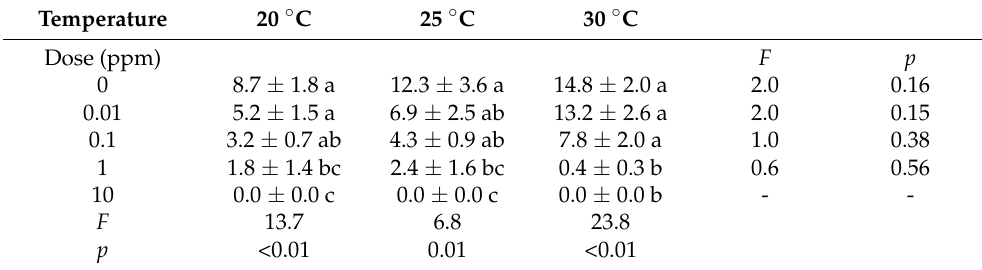
Table 6. Progeny production (adults per vial ± SE) of Prostephanus truncatus on maize treated with the SC formulation of chlorantraniliprole at five doses (0, 0.01, 0.1, 1 and 10 ppm) under three temperatures (20, 25 and 30 ◦ C) 45 days after the removal of parental adults. Within each column, means followed by the same lowercase letter are not significantly different (in all cases DF = 4, 44, Tukey–Kramer HSD test at 0.05). Within each row, means followed by the same uppercase letter are not significantly different (in all cases DF = 2, 26, Tukey–Kramer HSD test at 0.05). Where no letters exist, no significant differences were recorded. Where dashes exist, no analysis was